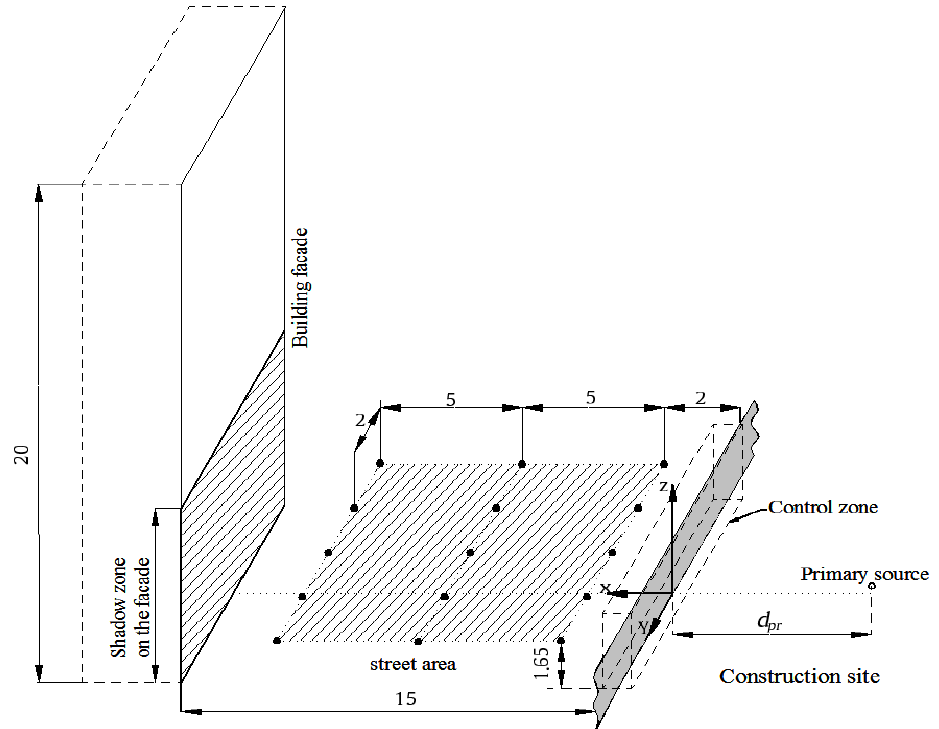
Figure 3. Schematic diagram of an infinite barrier and different target zones (dimensions are in meter).